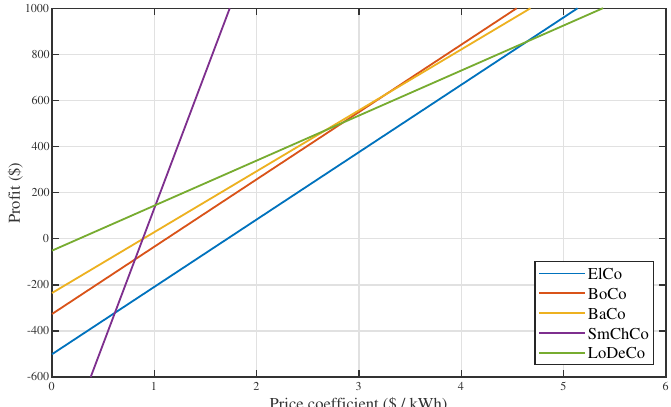
Figure 10. Profitability analysis for the different considered control